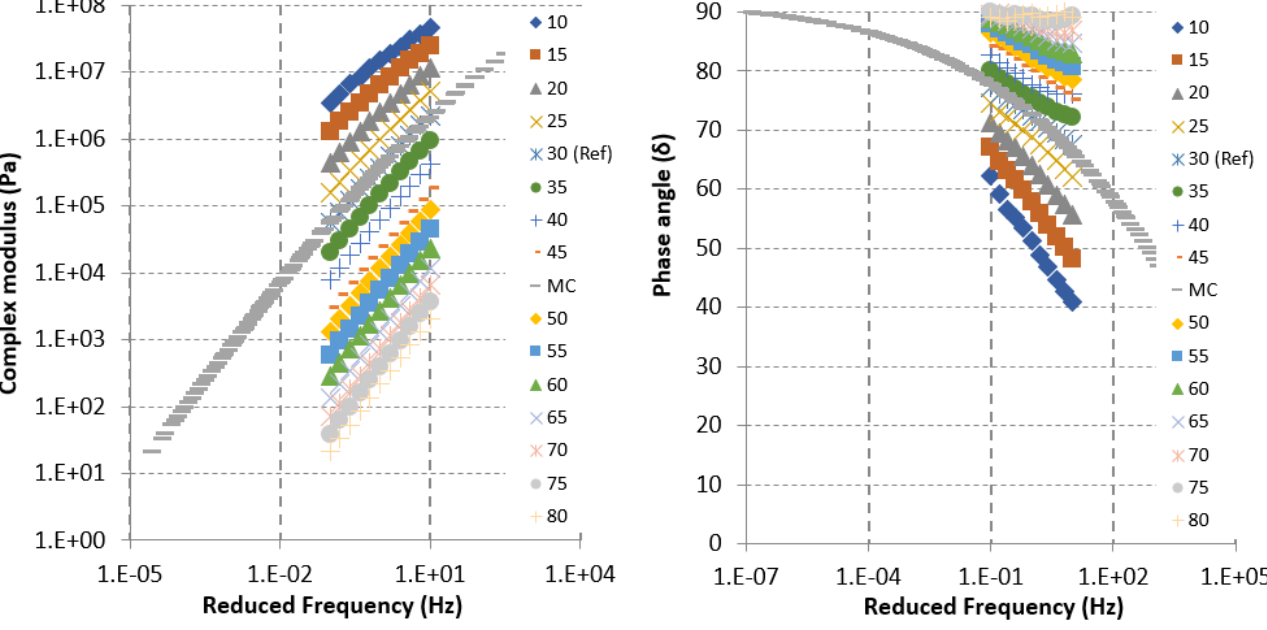
Figure 3. Master curves for complex modulus and phase angle.